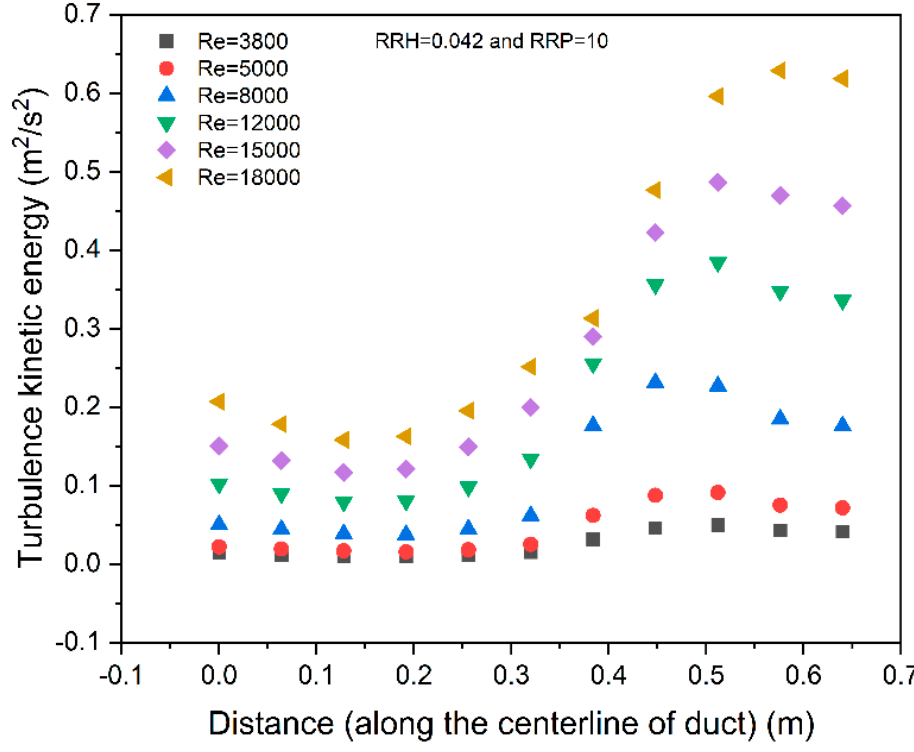
Figure 6. TKE as a function of distance along the centerline of the duct of a SAH for different Re . Figure 8 shows the contour plot of turbulence intensity ( TI ) at different rib pitches at an Re of 8000. The overall TI field as well as the degree of heat transfer can be visualized by looking at the patterns of TI contours around the ribs ahead of and behind the ribs. It is also seen that as the value of rib pitch increases, the value of the TI around the rib begins to decline. As can be seen from this demonstration, an RRP = 6.67 has a significant effect on the TI field, since it is capable of promoting better fluid mixing between the wall and core flow regions, resulting in higher temperature gradients across the heating duct wall. On the other hand, it can be seen that the temperature regions for all four scenarios are similar to one another and are practically spread uniformly throughout the flow, which is a sign of the strong mixing of the fluid flow. As the air passes over the roughened hot surface, heat is exchanged between the air and the surface. Due to convection, the air that is very close to the surface gets heated up very quickly. Because of the roughness of the surface, the primary hot layer interacts with the secondary cold air, and heat is transferred as a result of conduction and convection. Due to this, the temperature of the air at the surface of the duct is higher and decreases as it moves further away from the surface up to one third of the height of the duct. Figure 9 illustrates how the f r varies with the Re for a variety of RRP and RRH values. It has been found that the f r reduces as the Re increases, and the reason for this is due to the suppression of the viscous sub-layer. The generation of vortices that originate from the rib top generates an extra expenditure of energy, which ultimately results in an increased f r . For a given RRP and RRH value, Figures 5 and 9 show that the Nu r goes up as the Re goes up but the f r goes down. In contrast, the Nu r and f r values found for the rough SAH are dissimilar to those obtained for the smooth SAH . This is owing to the fact that roughness creates a discernible change in the properties of the fluid flow, which in turn promotes flow separations, reattachments, and the production of secondary